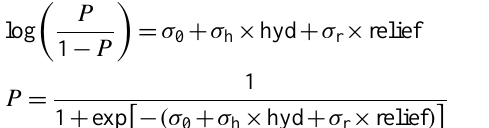
Fig. 5. Developed logistic curves for four geological Figure 5. Developed logistic curves for four geological properties